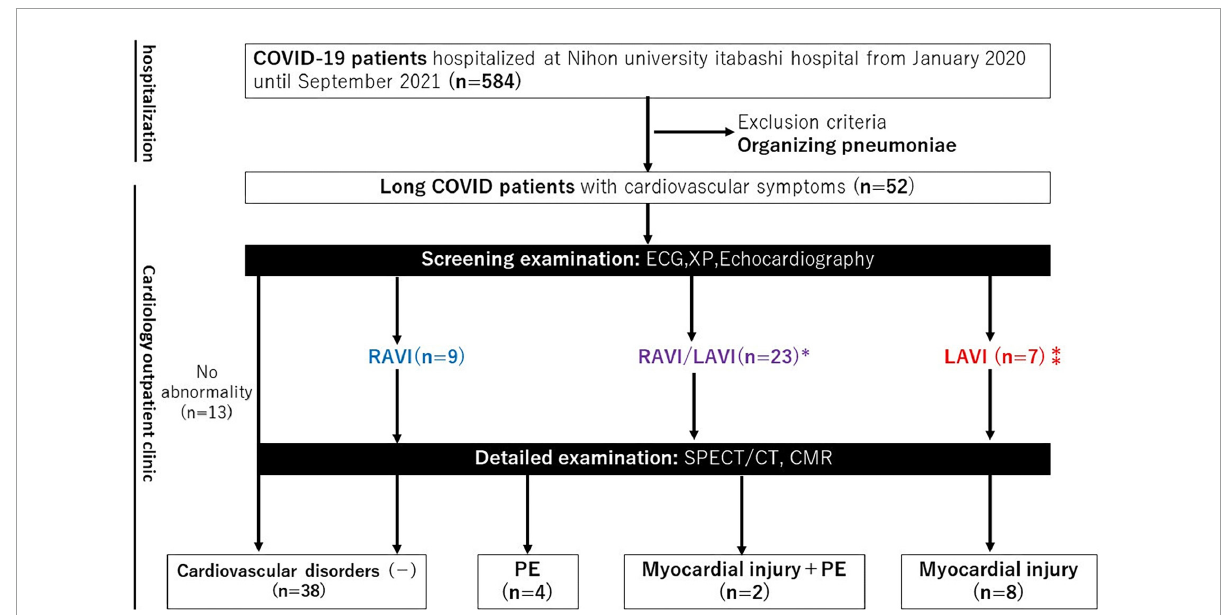
FIGURE1 Flow chart of the study patients. CMR, cardiac magnetic resonance; ECG, electrocardiogram; LAVI, left atrial and/or ventricular involvement; PE, pulmonary embolism; RAVI, right atrial and/or ventricular involvement; SPECT/CT, single photon emission computed tomography/computed tomography; XP, X-ray photograph. ∗ Contraindication of CMR ( n = 4), ∗ ∗ Contraindication to CMR ( n =